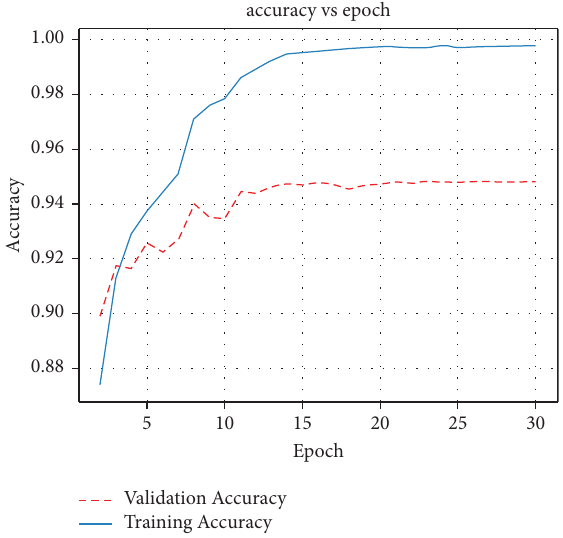
Figure 10: Observed accuracy for case 5.